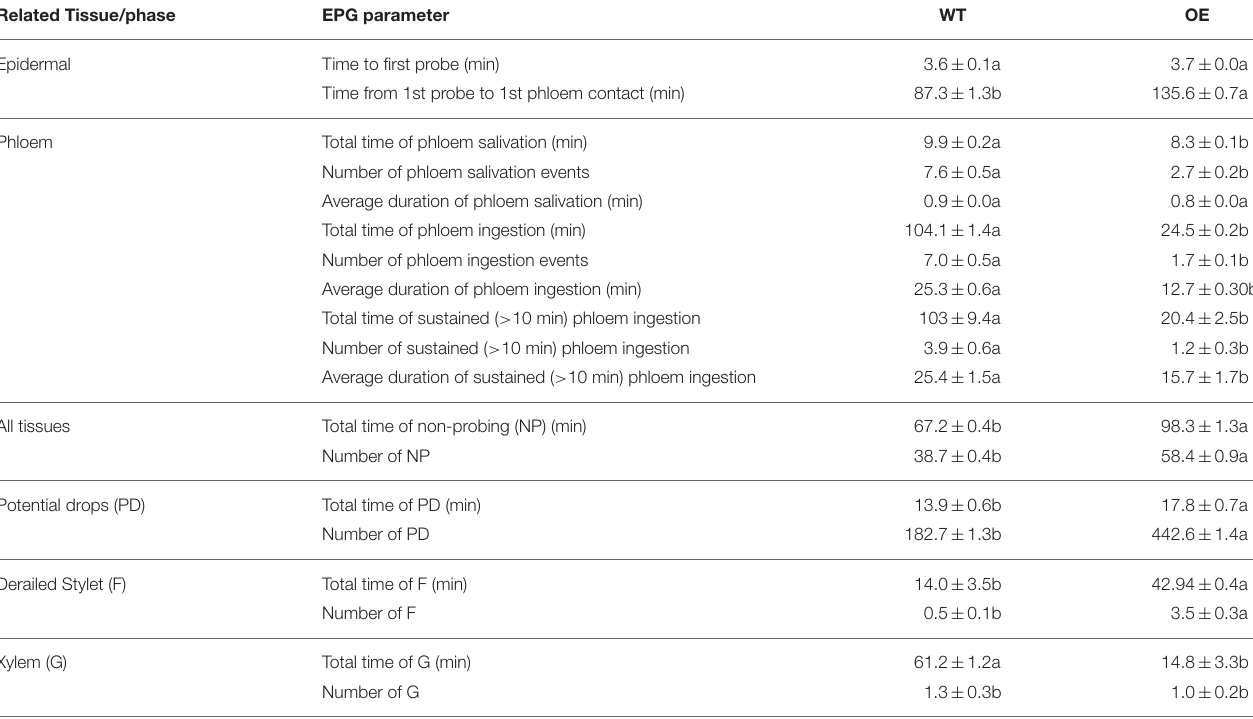
TABLE 1 | Electrical penetration graph (EPG) parameters considered and their relation to Myzus persicae feeding activity on Arabidopsis thaliana . Related